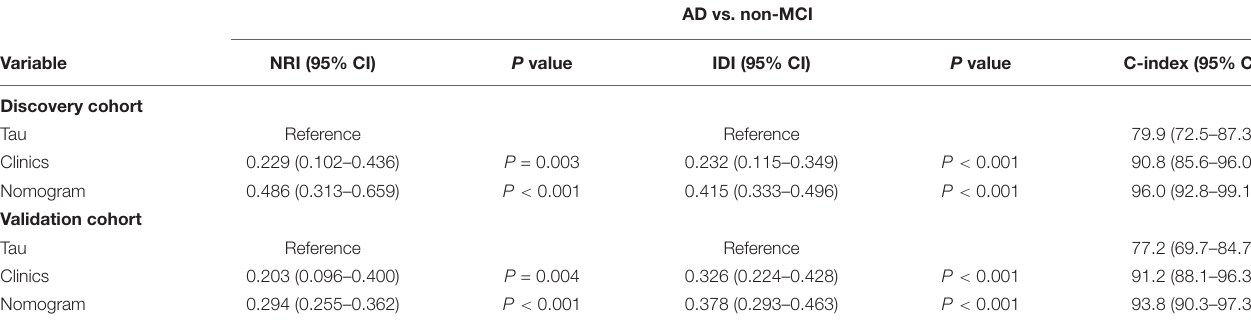
TABLE 1 | Evaluating the incremental predictive value and predictive performance of various models with NRI, IDI, and C-index between AD and non-MCI.